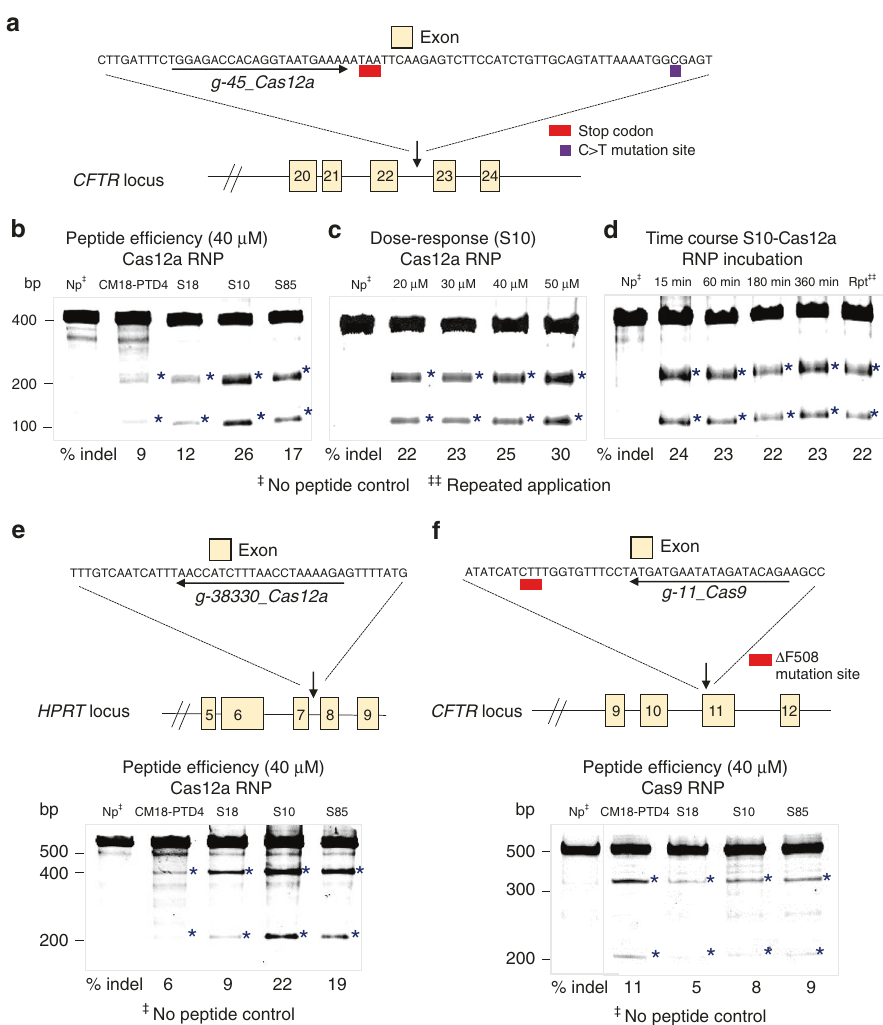
Fig. 2 Shuttle peptides deliver Cas12a and Cas9 RNPs to HAE. a Schematic showing CFTR locus in region of 3849 + 10C>T mutation (not to scale) and the sequence of the Cas12a guide RNA target. b Editing at the CFTR locus following delivery of Cas12a RNPs using four different peptides. Shuttle peptides were tested for Cas12a RNP delivery using gRNA targeting CFTR intron 22 – 23. Materials were applied for 15 min, cells were harvested 72 hr later for Surveyor assay; Indel% determined by Sanger sequencing. Asterisks denote bands observed with gene editing. Np indicates Cas12a RNP with no peptide. c S10 peptide dose – response on Cas12a RNP editing of CFTR locus. HAE transduced with fi xed RNP concentration [Cas12a]: 1.33 µ M; [gRNA]: 2 µ M and S10 peptide concentrations varied (20 – 50 μ M). Cells incubated with peptide-RNP for 15 min, and harvested 72 h later for Surveyor assay (Control: Cas12a RNP alone). d Effect of incubation time and repeated of peptide-Cas12a RNP delivery on editing. [S10]: 40 μ M; [RNP]: 40 µ M, applied for indicated times. After 72 h, cells prepped for Surveyor assay and Sanger sequencing (Np indicates Cas12a RNP with no peptide, incubated for 3 h; Rpt denotes repeated application of peptide/RNP× 3 daily doses). n = 3 donors. e Schematic of HPRT1 locus and Cas12a guide RNA target sequence along with editing ef fi ciency on delivery of RNPs. Screen of four peptide formulations at 40 μ M concentration, [RNP]: 2.5 µ M; [gRNA]: 2.0 μ M on primary HAE. Indicated peptide-RNP applied for 3 h; 72 hr later, cells were processed for Surveyor assay. Asterisks denotes genome editing. n = 3 donors. f Schematic of the CFTR locus